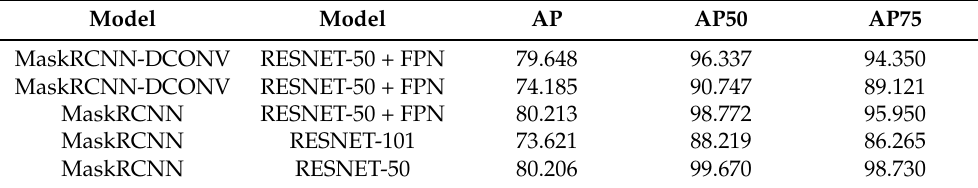
Table 2. Ablation study with different backbones and deformable